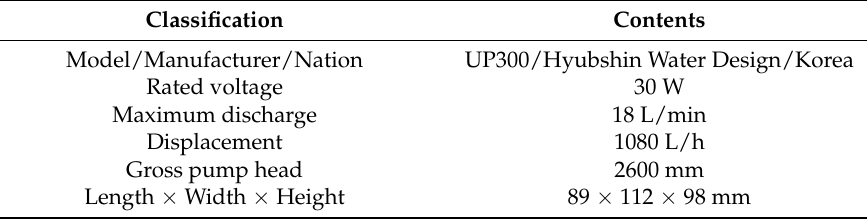
Table 2. Specifications of the water